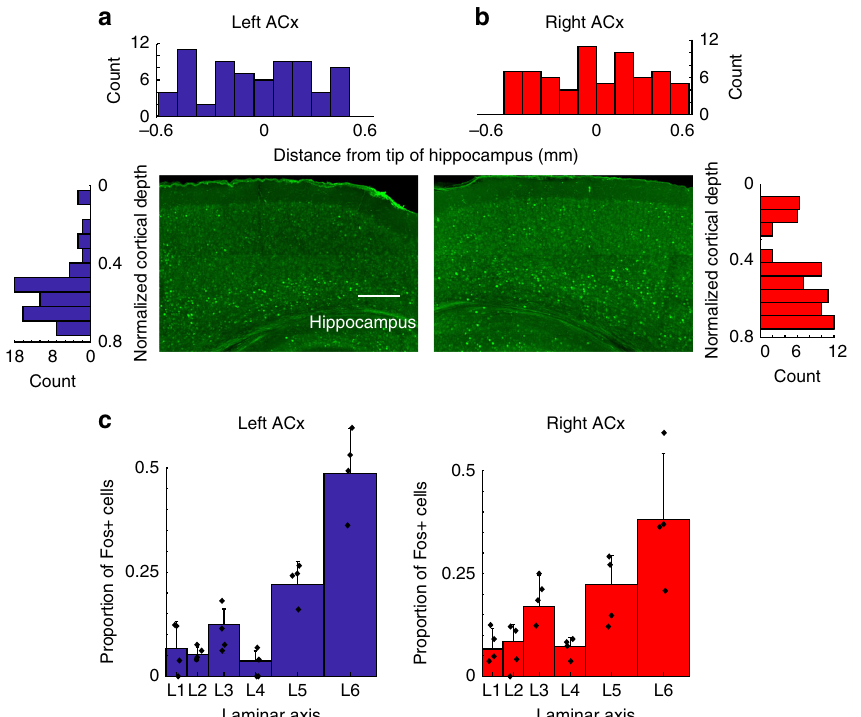
Fig. 8 Hearing onset Fos activity in response to vocalizations. a , b Quanti fi cation of immuno Fos staining data at hearing onset (P12 – 14) showing that there is no difference in the number of Fos-positive neurons between the left and right ACx. Scale bar 0.2 mm. c Population plots showing that although there is no difference in the total number of active cells between the hemispheres, there is a signi fi cant difference in the activation of super fi cial and deep layers ( n = 3 mice). All data are presented as mean ±